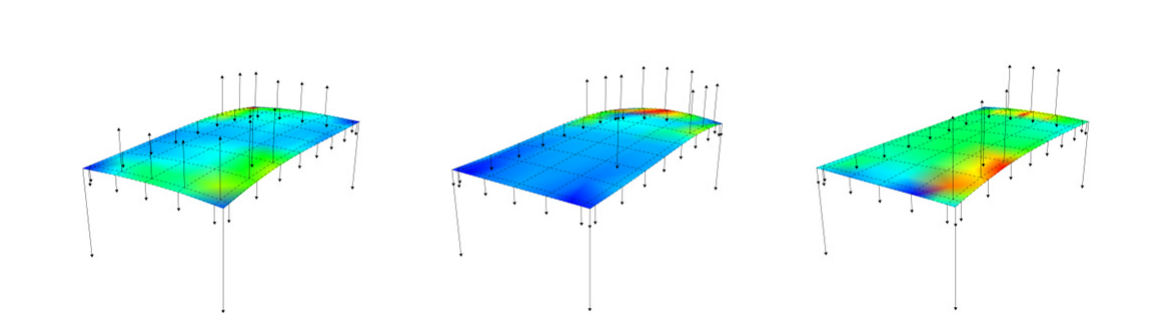
Fig. 2 Variable single sheet curvatures and applied bending force equilibrium.